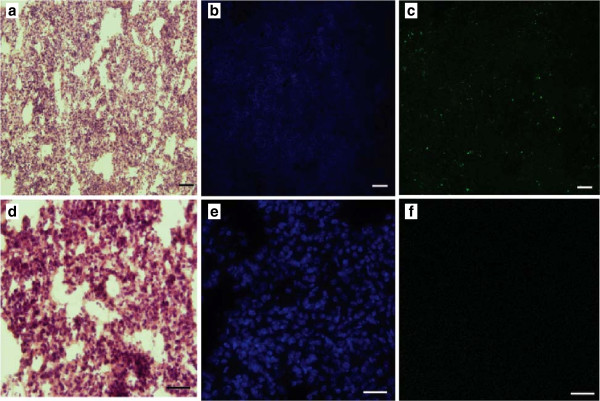
Administration of nebulized pDNA induces gene expression in the murine lung. Confocal microscopy of mouse lung parenchyma cryosections 24 hours after (a, b, c) dosage of 75 μg with post-nebulized pVR1020–YFP in 0.9% NaCl aqueous solution, compared to an (d, e, f) untreated case (scale bars: 100 μm). The lung structure (a, d) and (b, e) cell nuclei are indicated with a counterstain of hematoxylin and eosin, and with DAPI, respectively. Lung cells expressing YFP from instilled pVR1020–YFP appear green in (c) the treated lung sample; note the absence of green in the (f) untreated sample. The control lung samples were imaged at a higher resolution to confirm the absence of YFP response.